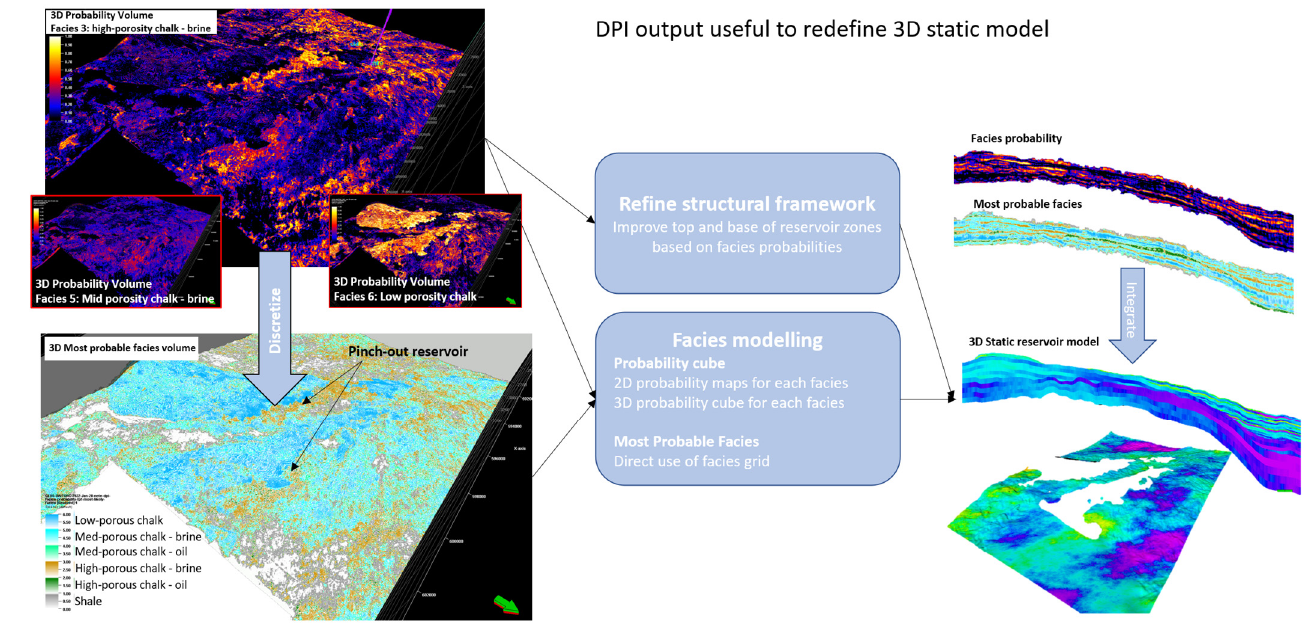
Figure 19. Output of the DPI tool for reservoir modeling/characterization purposes.